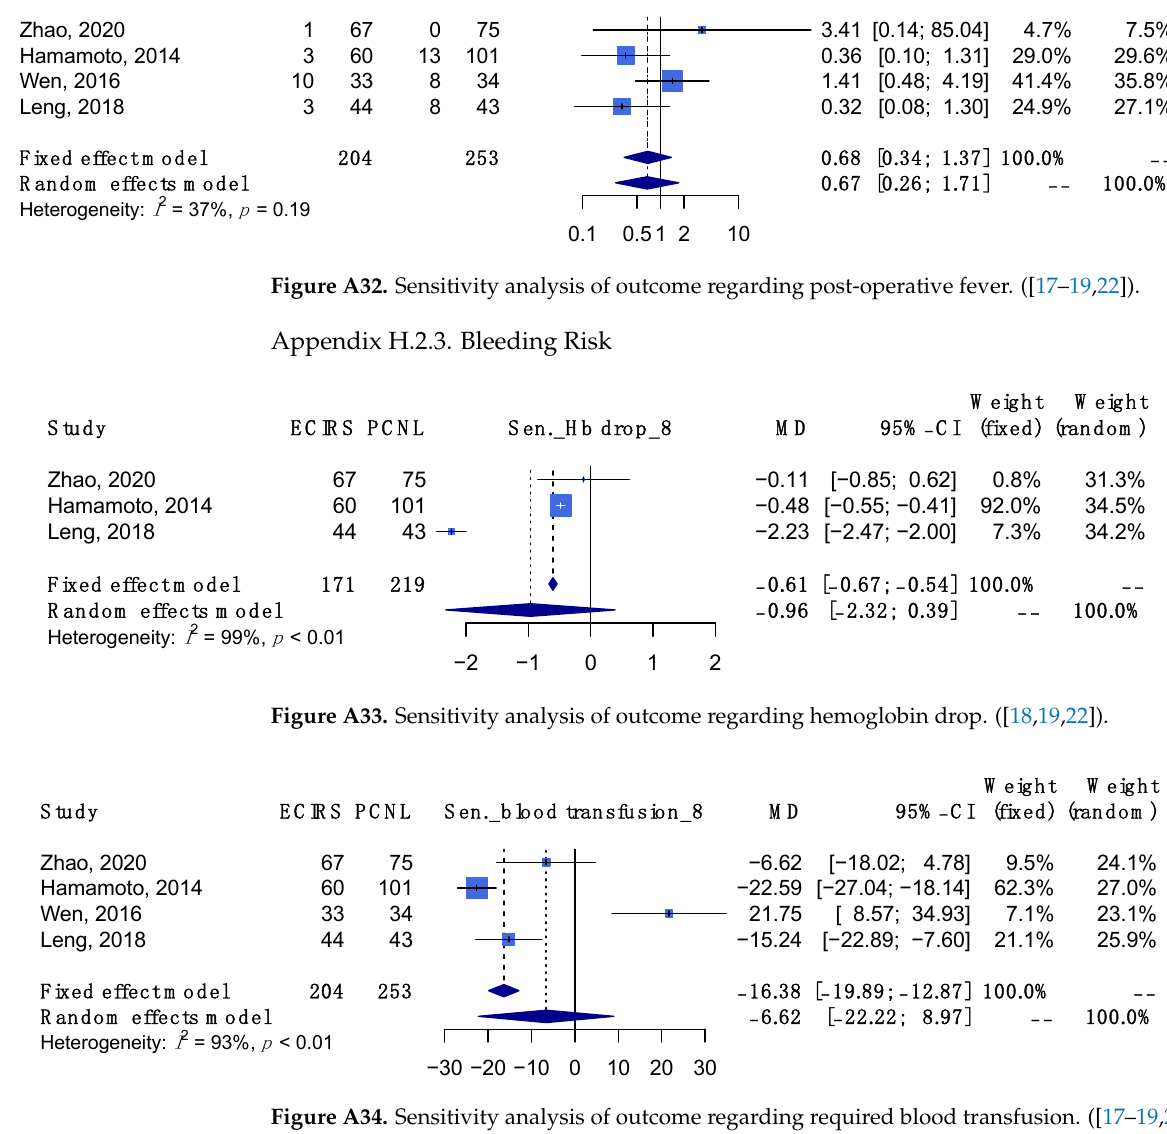
Figure A34. Sensitivity analysis of outcome regarding required blood transfusion. ([17–19,22])